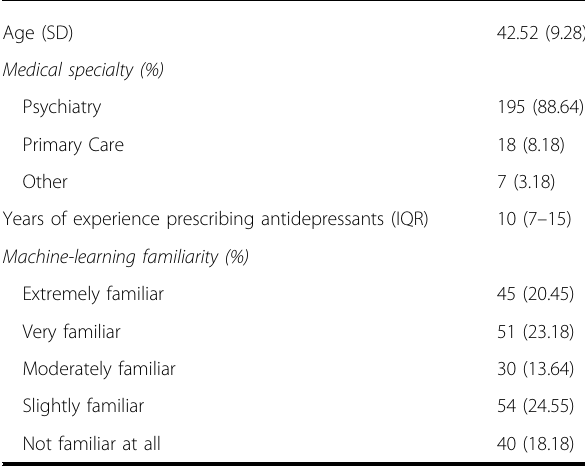
Table 1 Descriptive statistics of the 220 study participants, including age, medical specialty, and years of experience prescribing antidepressants, and machine- learning familiarity.